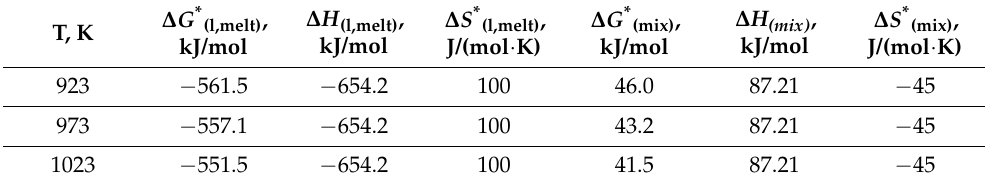
Table 5. Thermodynamic values of iron fluoride (II) formation in the (0.66LiF–0.34BeF 2 ) melt at 923 K. ∆ H ∆ H ∆ G * ∆ S * ∆ G * ∆ S * (mix) , (l,melt) , (l,melt) , (l,melt) , (mix) , (mix) , T, K kJ/mol kJ/mol kJ/mol J/(mol · K) kJ/mol J/(mol · K) 923 − 561.5 − 654.2 100 46.0 87.21 − 45 973 − 557.1 − 654.2 100 43.2 87.21 − 45 1023 − 551.5 − 654.2 100 41.5 87.21 −